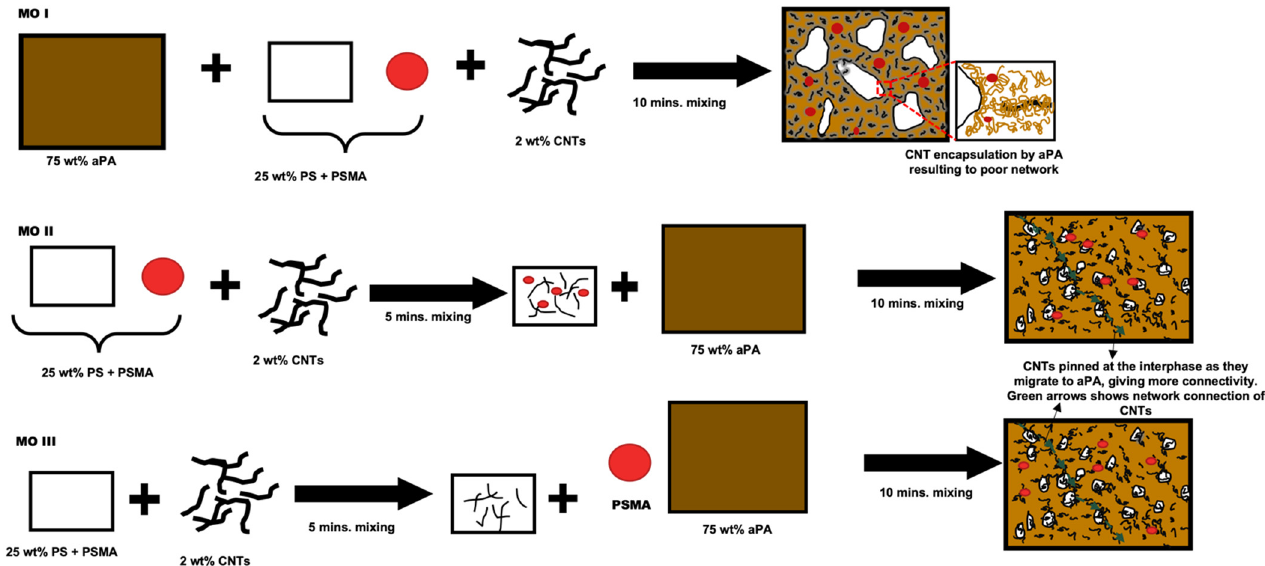
Figure 11. Schematic illustration of the mixing protocols.